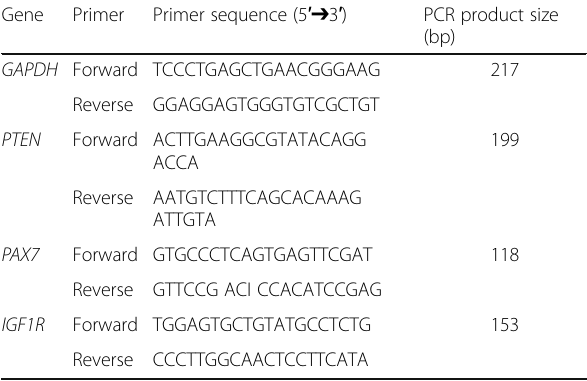
Table 2 Primer sequences for quantitative gene expression